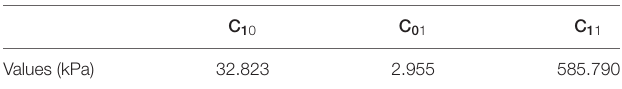
TABLE 2 | Parameters of Mooney–Rivlin model for porcine leaflet